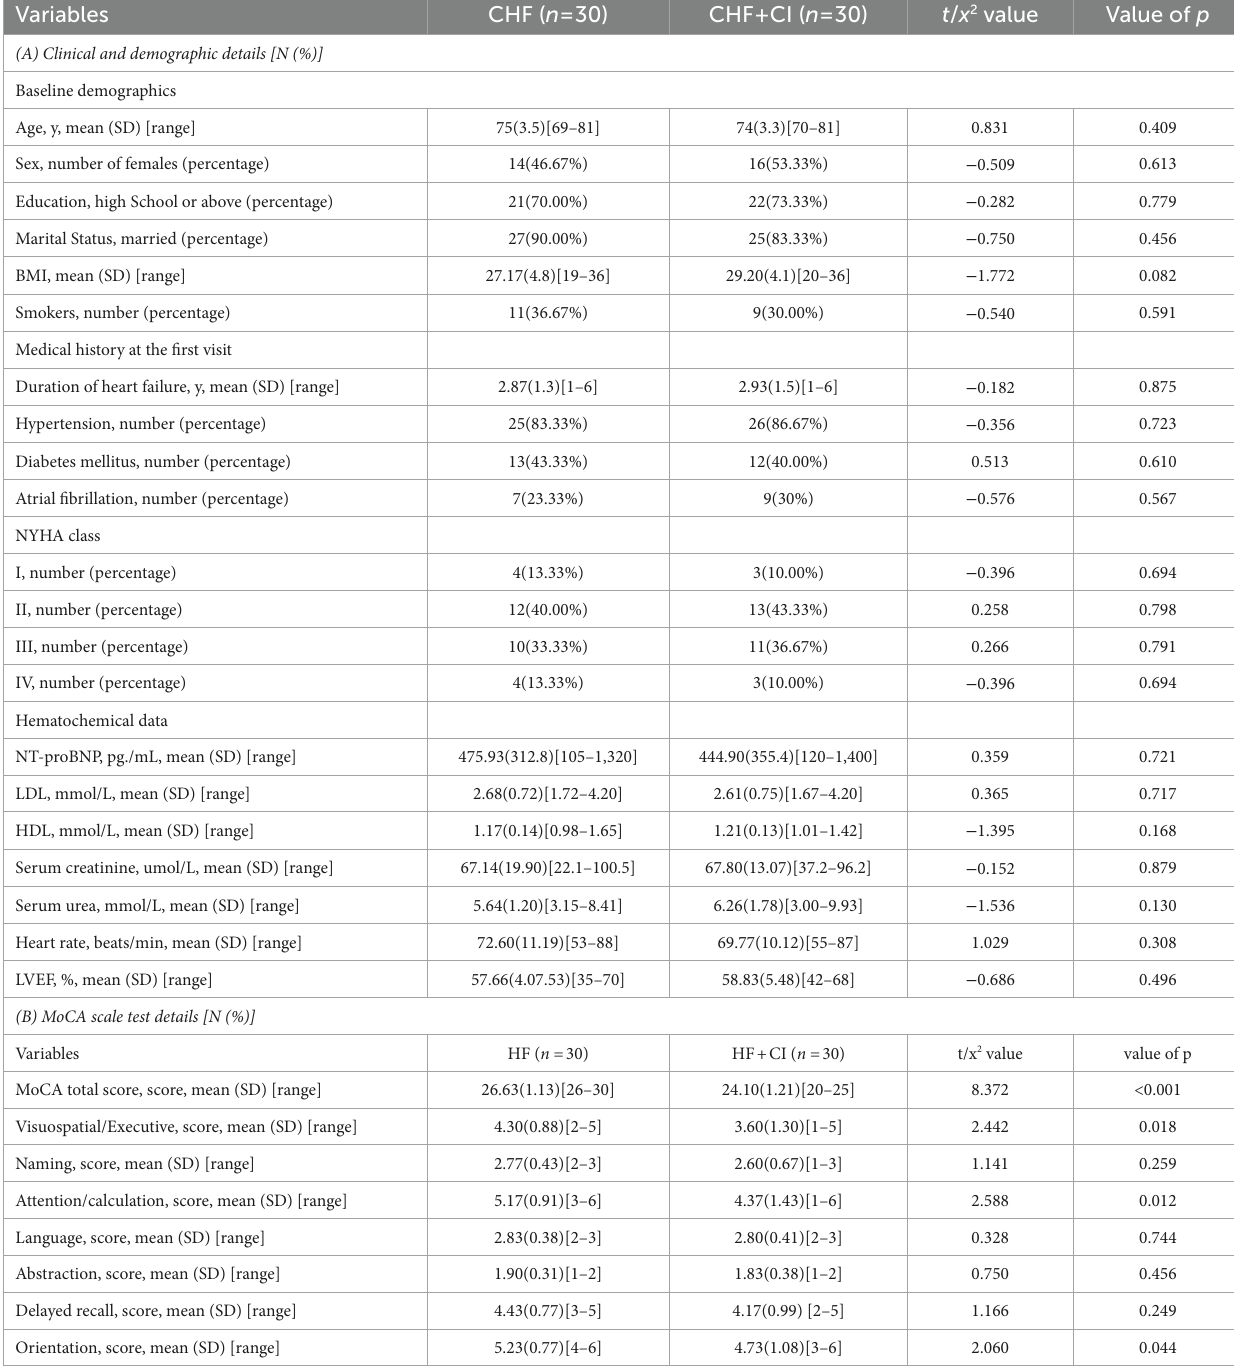
TABLE 1 All data are expressed as mean (SD) [range].